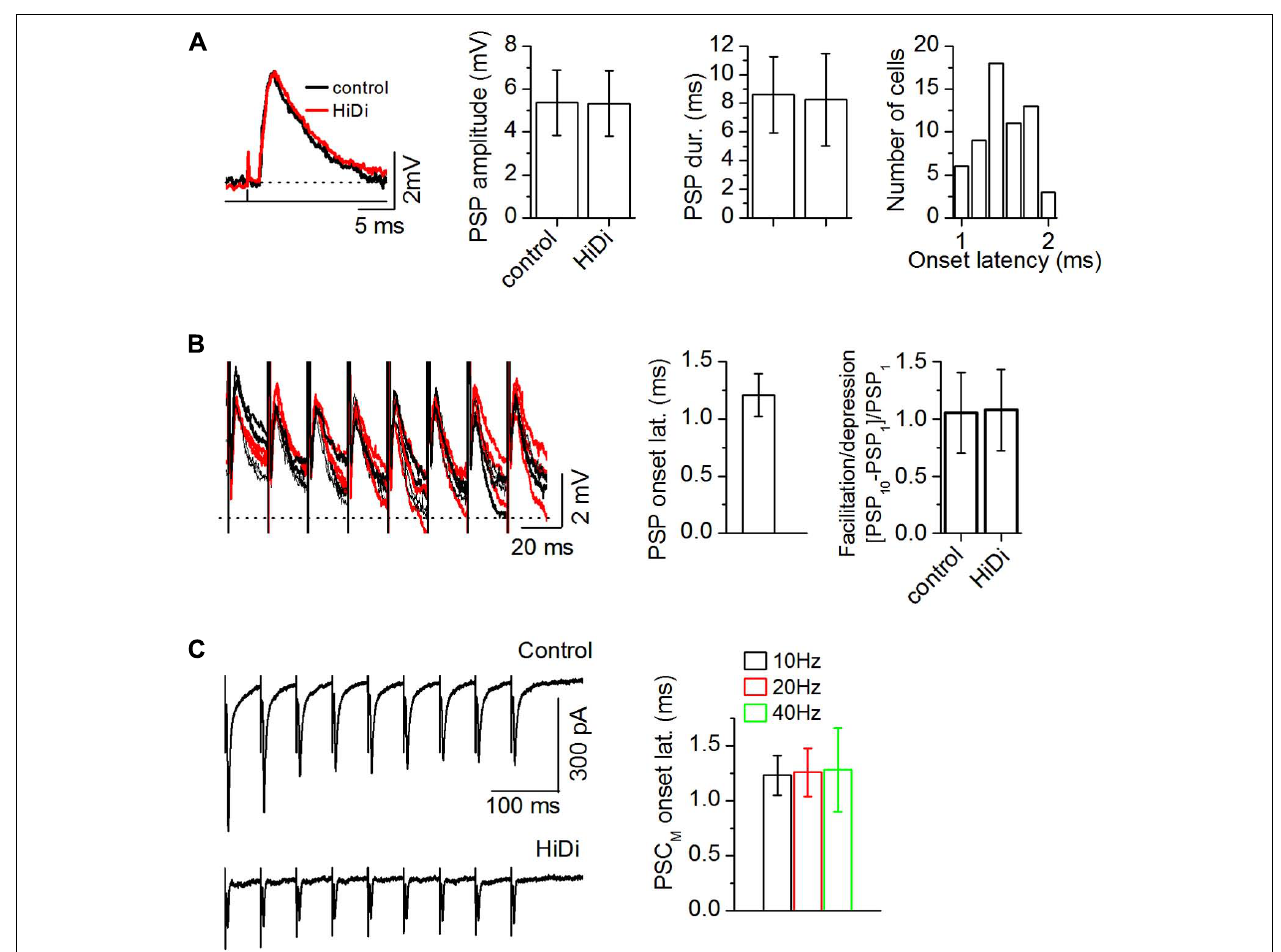
HiDi throughout the train (20–50 Hz trains; PSP amplitudes: F 9,290 = 1.39; p = 0.19), 33 cells. Middle: PSP onset latencies during successive stimuli varied by less than one SD (1.21 ± 0.19 ms; 21 cells) verifying a monosynaptic input. Average of the first 5 pulses in 20 Hz trains of 10 pulses/train, 21 cells. Mean and SD. Right: ratio of the change in PSP peak amplitude between the first and last stimulus pulses, 20 Hz train, 10 pulses, 33 cells; Mean and SEM ( t 65 = 1.16; p = 0.25). (C) Left: recordings of synaptic currents evoked by a 20 Hz LL stimulus train with non-minimal ( < 10% failure rate) shock strengths (50% above threshold). Stimulus strength was adjusted to evoke a depressing response during the train. Holding potential − 66 mV. Right: onset time of the HiDi-insensitive component (PSC M ) during stimulus trains. Data are plotted for 10, 20, 40 Hz trains. Fifty-one cells were tested. Forty-two